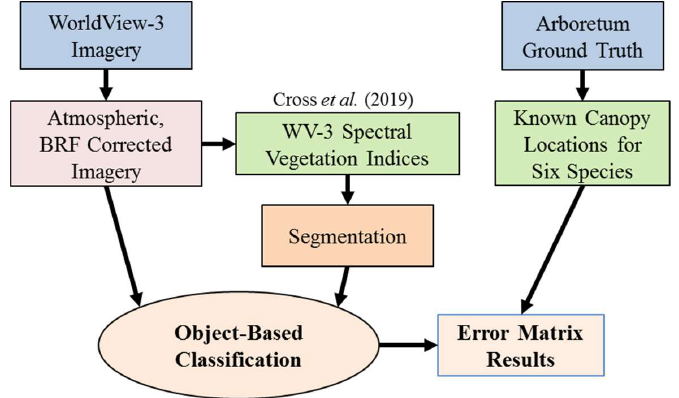
Figure 1. A flowchart of the data preparation and analysis process described in this study.